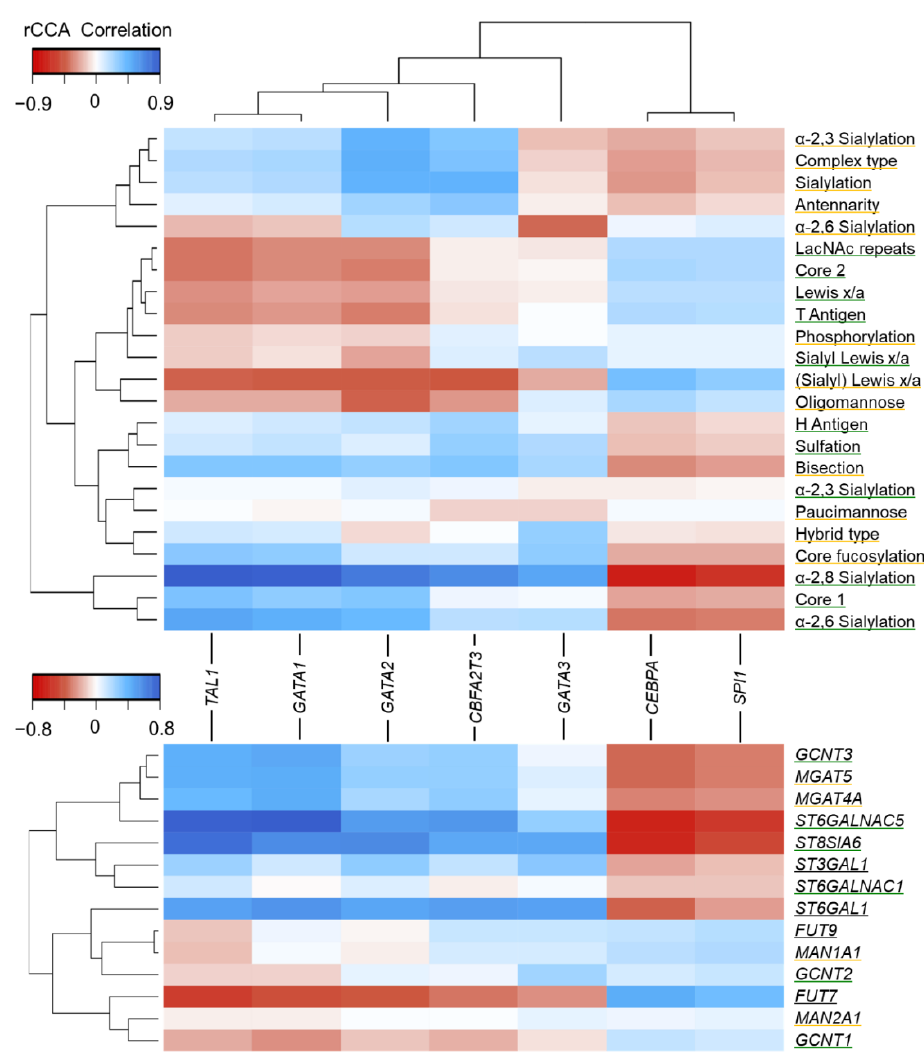
Figure 5. Regularized canonical correlation analysis (rCCA) of N - and O -glycan features and GSTs, respectively, with transcriptomics data of hematopoietic transcription factors. Correlation values are depicted in blue (positive correlation) and red (negative correlation), as illustrated in the provided color scale. Rows and columns were arranged based on hierarchical clustering. Glycan features and GSTs are underlined in yellow if related to N -glycans, in green if related to O -glycan or black if related to both.